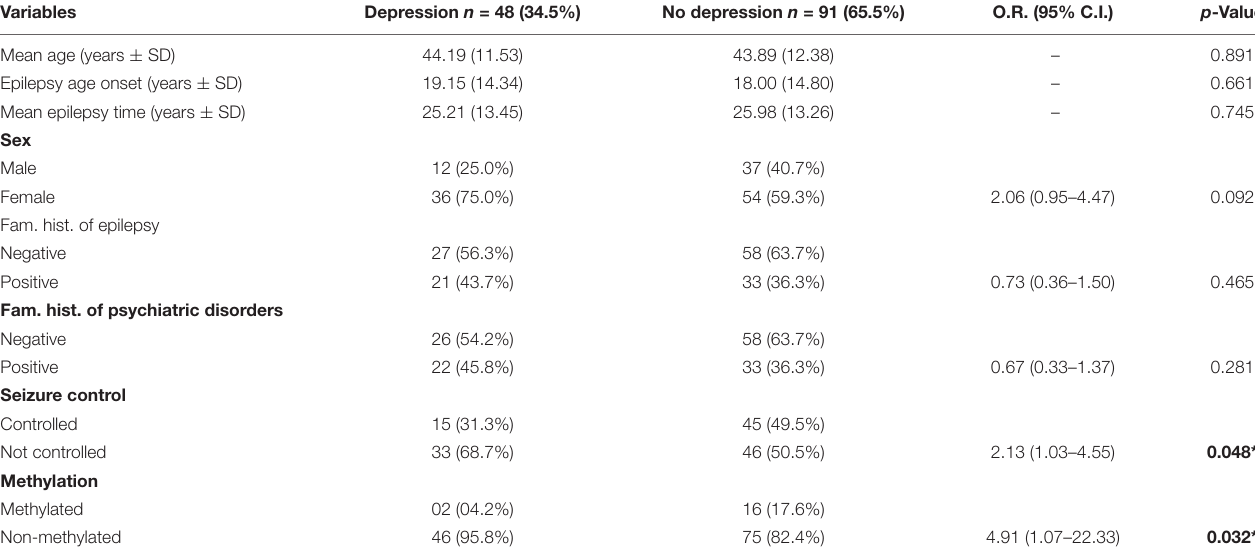
TABLE 5 | Variables according to life history of depression in TLE patients.